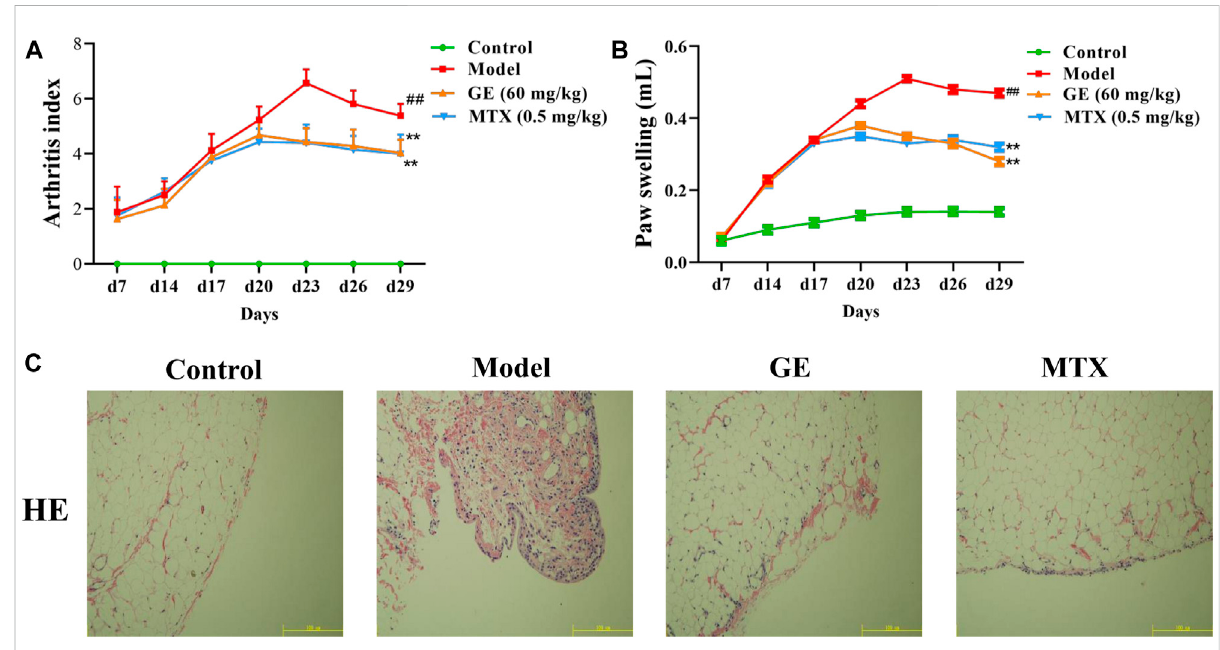
FIGURE 2 EstablishmentandevaluationofAAmodelrats andthetherapeuticeffect ofGE.AAmodelrats weretreatedwithGE for14days. (A) The arthritis indexofratsineachgroupwasmeasured,includingcontrolgroup,modelgroup,GEadministrationgroupandMTXpositivemedicinegroup. (B) The degree of secondary paw swelling was measured. (C) Histopathological examination of synovial in AA rats. The data represent the means ± SD deviation of six samples in an independent experiment. ## p < 0.01, compared with control group; ** p < 0.01, compared with model group; n =